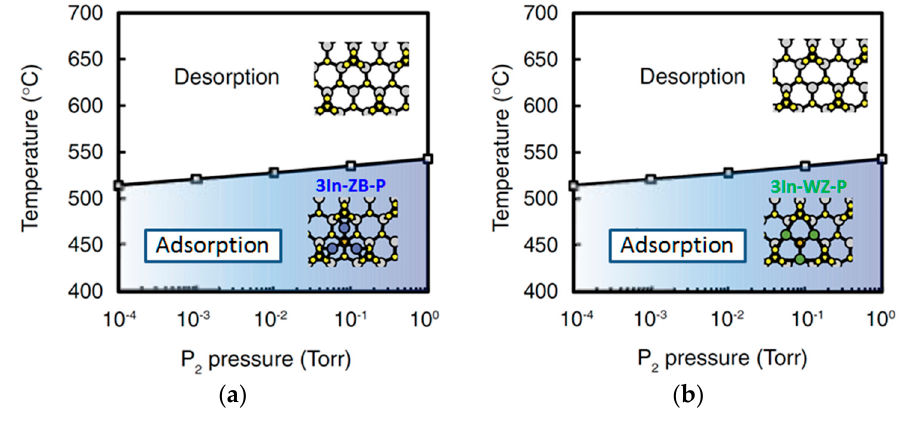
Figure 18. Calculated phase diagrams of ( a ) 3In-ZB-P and ( b ) 3In-WZ-P adsorbed surfaces as functions of temperature and P 2 pressure. In pressure is taken to be 3.3 × 10 − 3 Torr. Colored regions correspond to the atom-adsorbed regions. Reprinted with permission from [95]. Copyright (2011) by the Japan Society of Applied Physics.